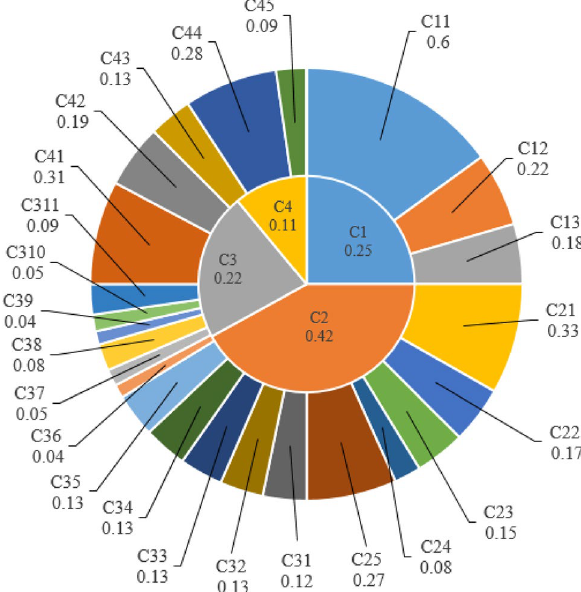
Figure 2. Weights of criteria and